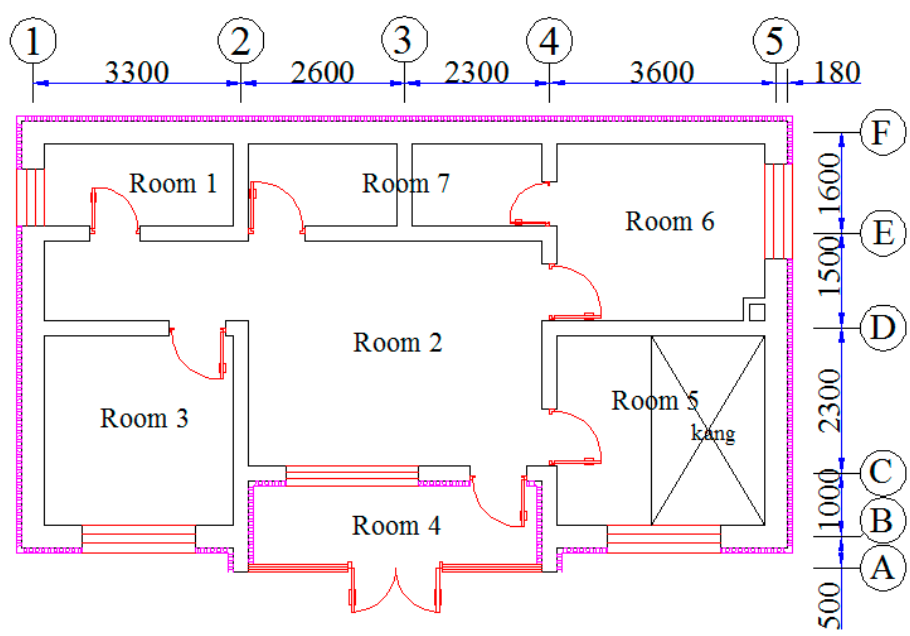
Figure 2. The detailed dimensions and the function of each room.